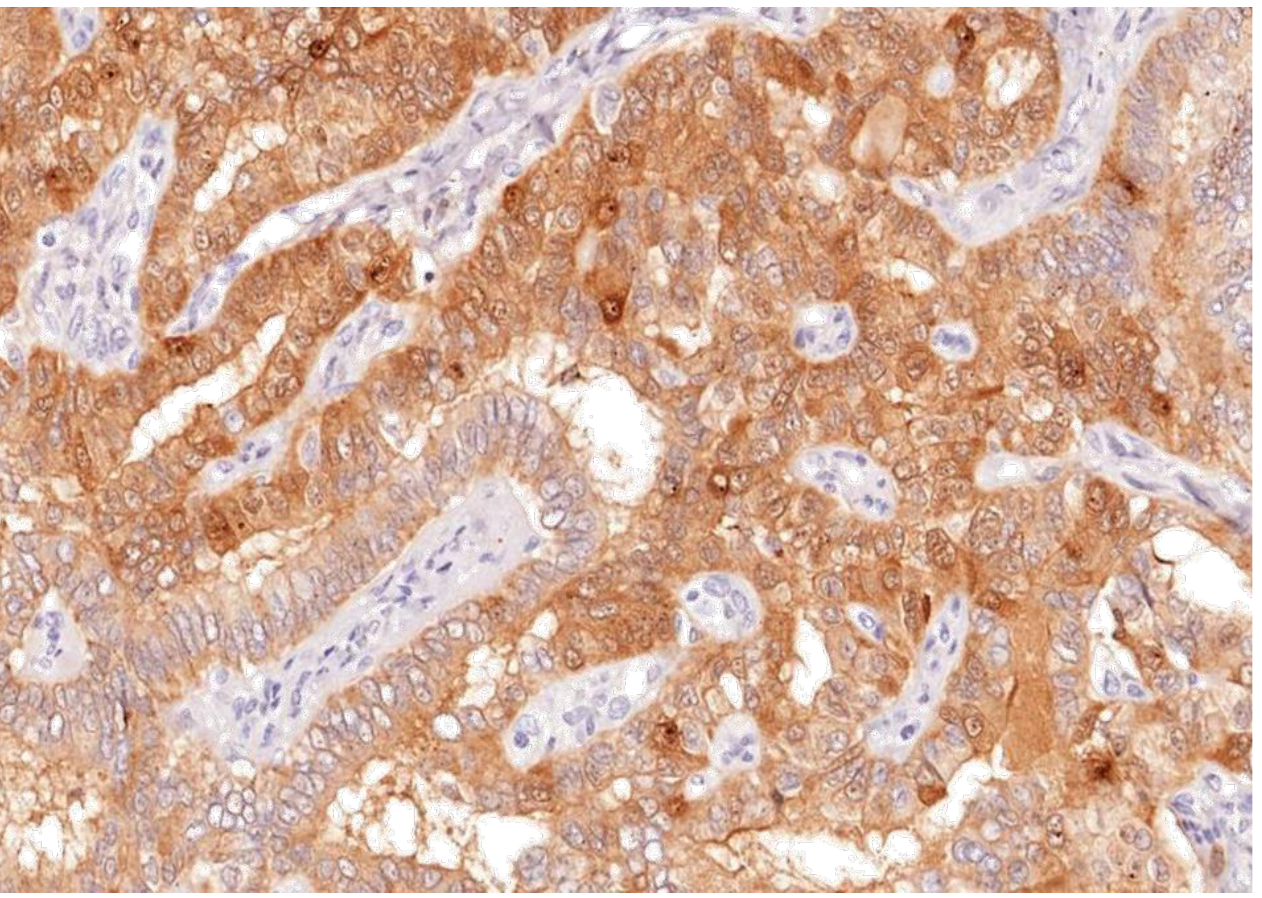
Figure 9. Galectin-3 staining shown nuclear and membranous staining as brown stain after IHC in apillary thyroid carcinoma; (labelled) (Magnification ×100).